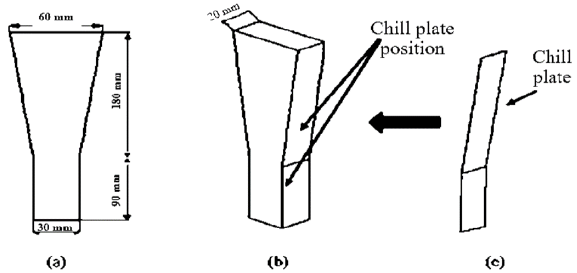
Figure 1: Pattern and chill plate; (a) the type and dimension of pattern; (b) 3D view of the pattern and position chill plate on the pattern; (c) chill